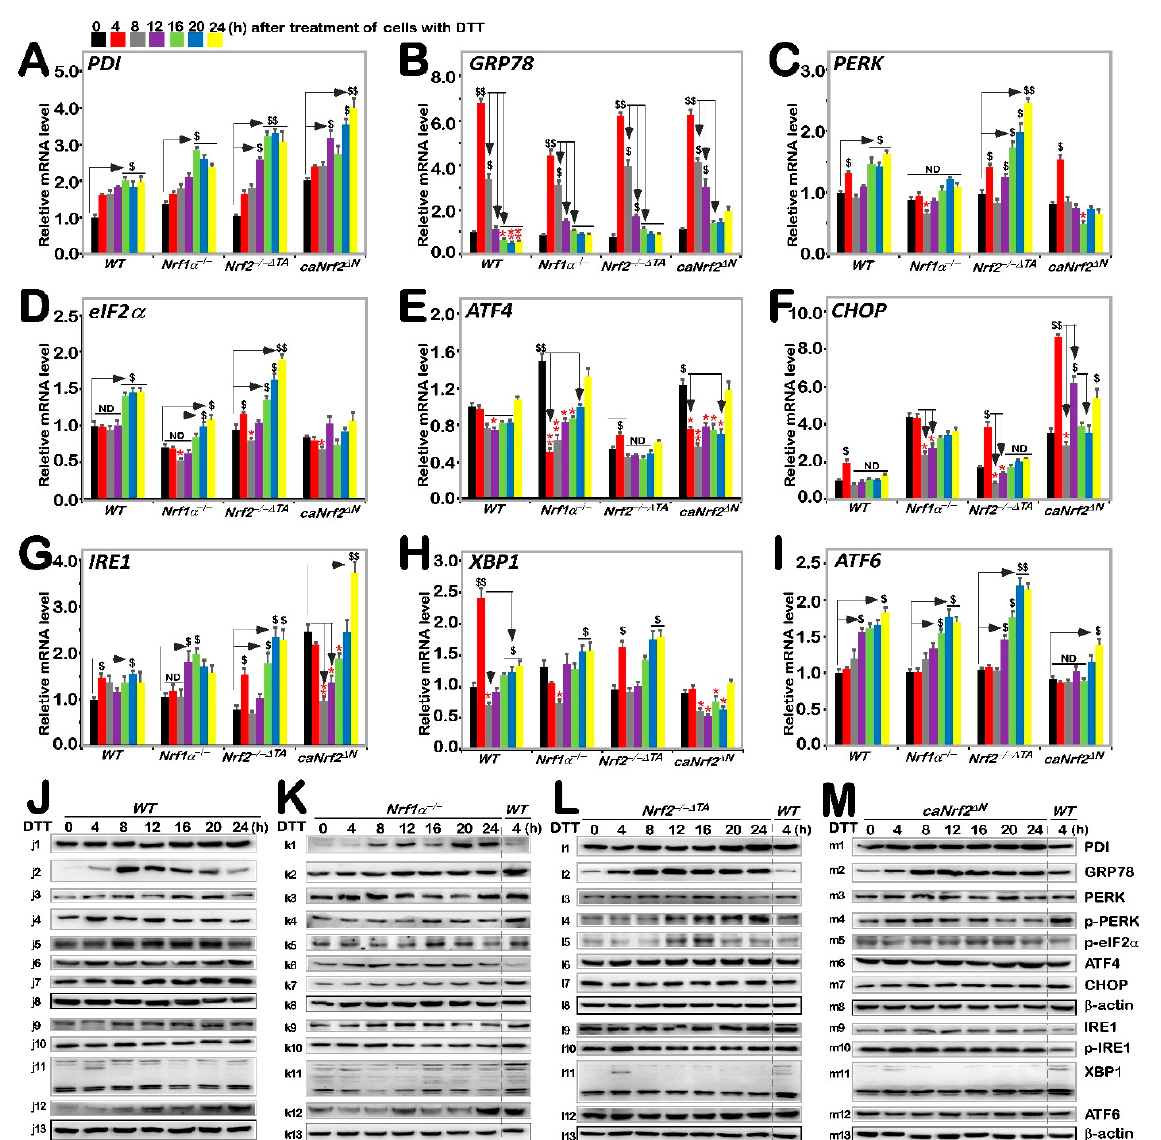
Figure 3. Distinct roles of Nrf1 and Nrf2 in the ER stress response induced by DTT. Four genotypic cell lines of WT , Nrf1 α − / − , Nrf2 − / − △ TA and caNrf2 △ N were or were not treated with 1 mM DTT for 0 to 24 h, before basal and DTT-inducible mRNA expression levels of those ER stress-related genes were determined by RT-qPCR. Those genes included PDI ( A ), GRP78 ( B ), PERK ( C ), eIF2 α ( D ), ATF4 ( E ), CHOP ( F ), IRE1 ( G ), XBP1 ( H ) and ATF6 ( I ). The data were shown as fold changes ( mean ± SD , n = 3 × 3 ), which are representative of at least three independent experiments being each performed in triplicate. Significant increases ( $ , p < 0.05; $$ , p < 0.01 ) and signif- icant decreases ( * p < 0.05; ** p < 0.01 ), in addition to the non-significance (ND), were statistically analyzed when compared with their corresponding controls (measured at 0 h). The main tendencies of up- and down- regulatory changes of different genes after 1 mM DTT intervention are also shown in Figure S5B. After similar treatment of WT ( J ), Nrf1 α − / − ( K ), Nrf2 − / − △ TA ( L ), and caNrf2 △ N ( M ) cell lines for distinct lengths of time (i.e., 0, 4, 8, 12, 16, 20, 24 h), those inducible protein changes of PDI ( j1 – m1 ), GRP78 ( j2 – m2 ), PERK